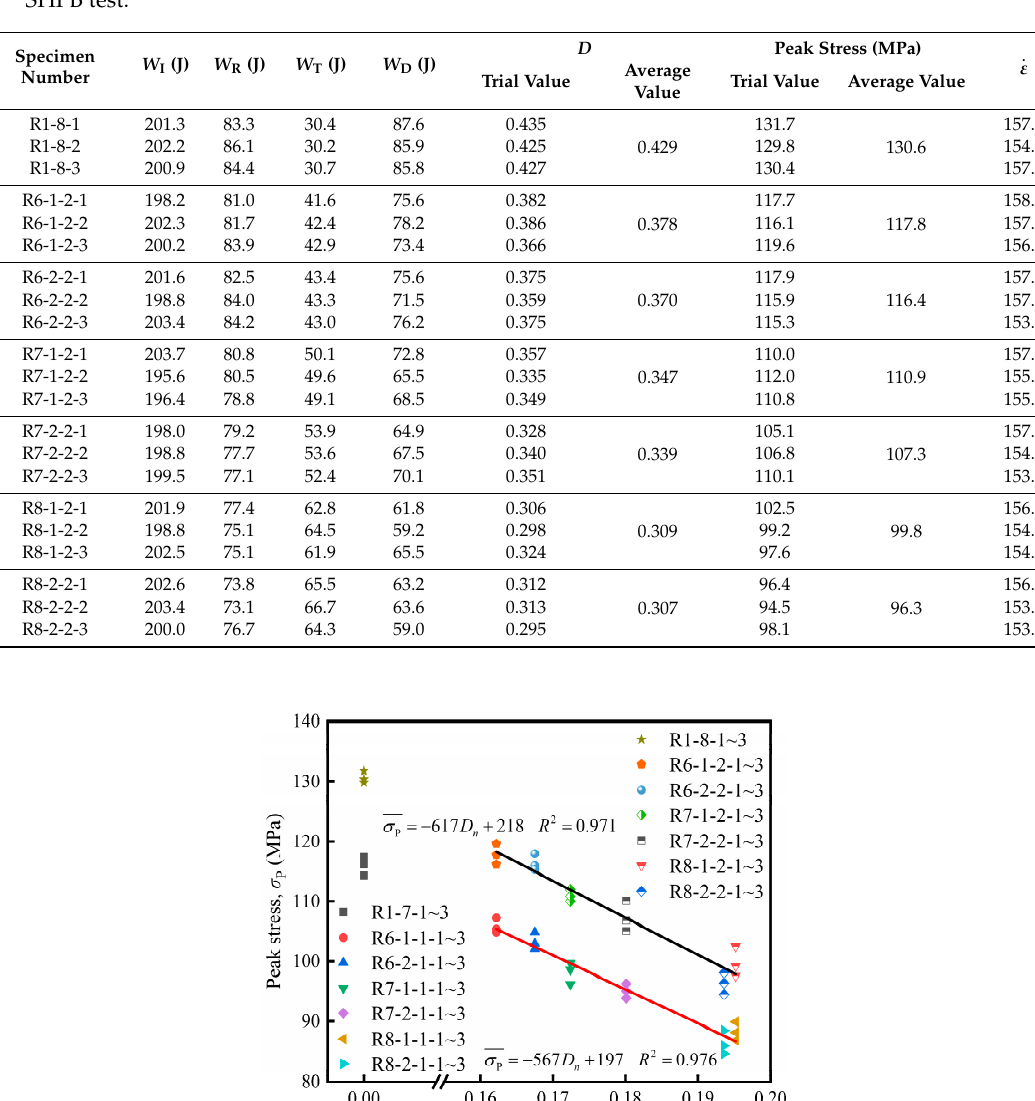
Table 7. The dissipated energy condition of the rock specimen under a 0.35 MPa impact pressure in the SHPB test.